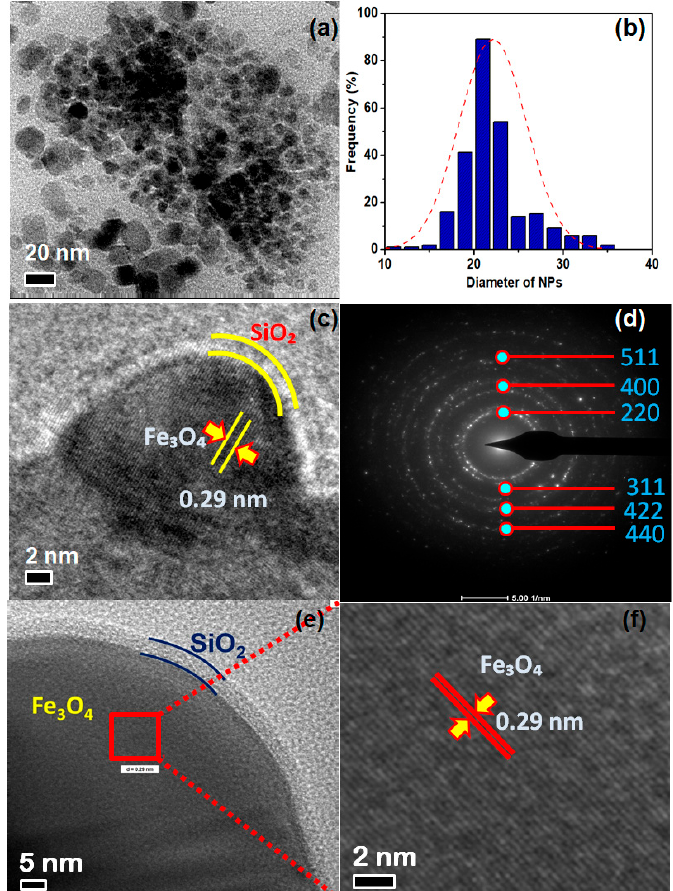
Figure 4. TEM bright field image of ( a ) Fe 3 O 4 @SiO 2 MNPs with ( b ) size distribution histogram of prepared NPs of 15–20 nm ( c ); ( d ) SAD pattern of Fe 3 O 4 @SiO 2 MNPs; ( e , f ) High-resolution TEM imaging of ( c ).